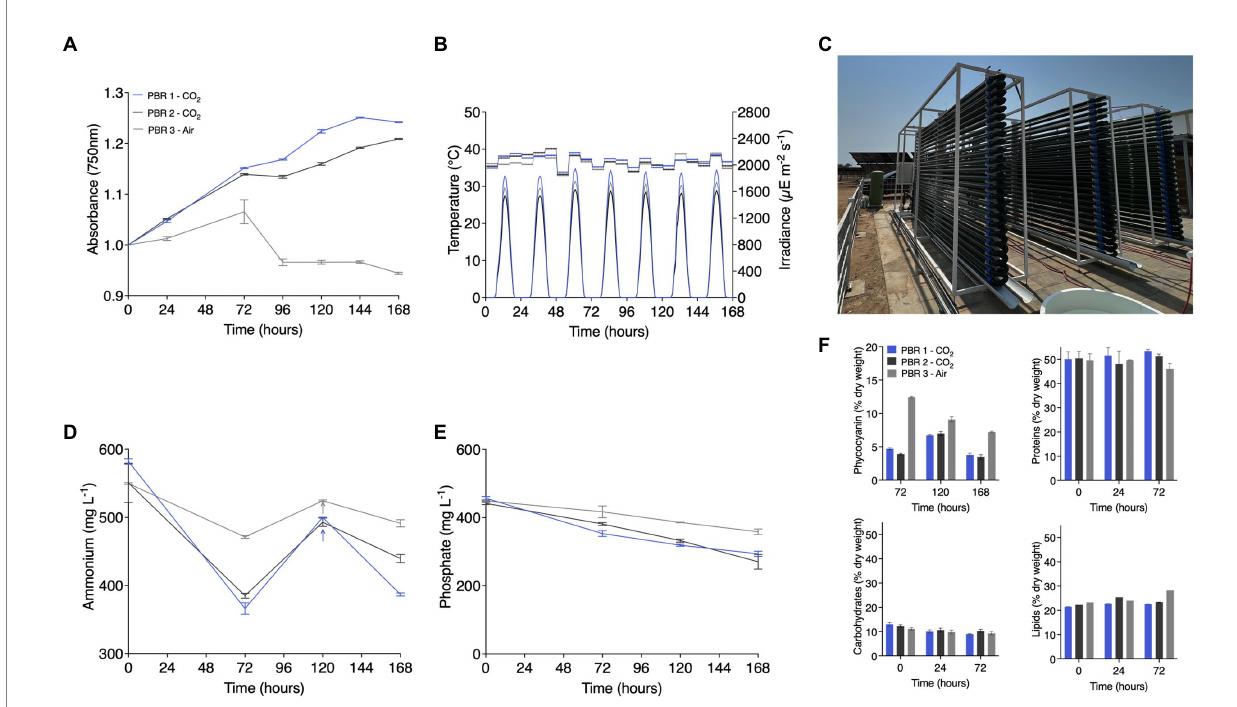
FIGURE 3 Three 1 m 3 tubular photobioreactors were inoculated with the stationary phase culture of Figure 2. (A) OD 750nm , (B) temperature, and irradiance were measured throughout the cultivation. The three reactors (C) were given beverage grade (PBR 1–CO 2 ), Industrially reclaimed “green” CO 2 (PBR 2–CO 2 ), or atmospheric air (PBR 3–Air). The reactors each experienced slightly different irradiances based on their position to one another, with the outermost having higher incident light intensities. (D) Ammonium and (E) Phosphate levels were recorded at different intervals, and supplemental ammonium solution was added to all reactors after 120 h. (F) Culture biomass was analyzed at different time-points for phycocyanin, protein, carbohydrate, and lipids